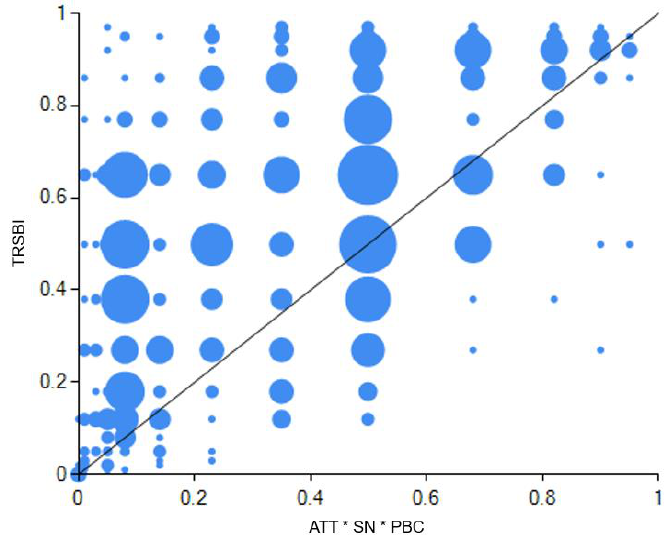
Figure 3. Configuration 1 explanation in the mode of tourist resource-saving behavioral intentions.